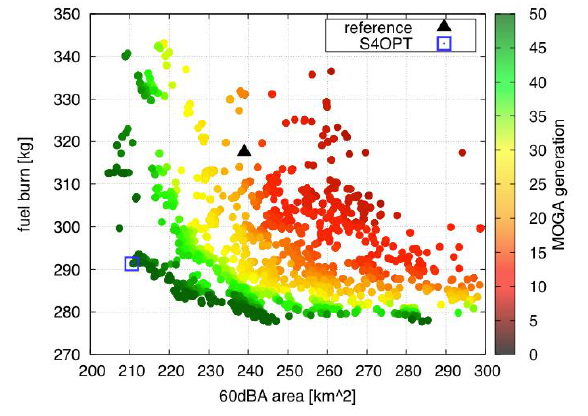
Figure 7: Multi-objective optimization of takeoff for a mid-range, twin-engine aircraft. The blue square solution was selected as the 5 % deviation from the minimum